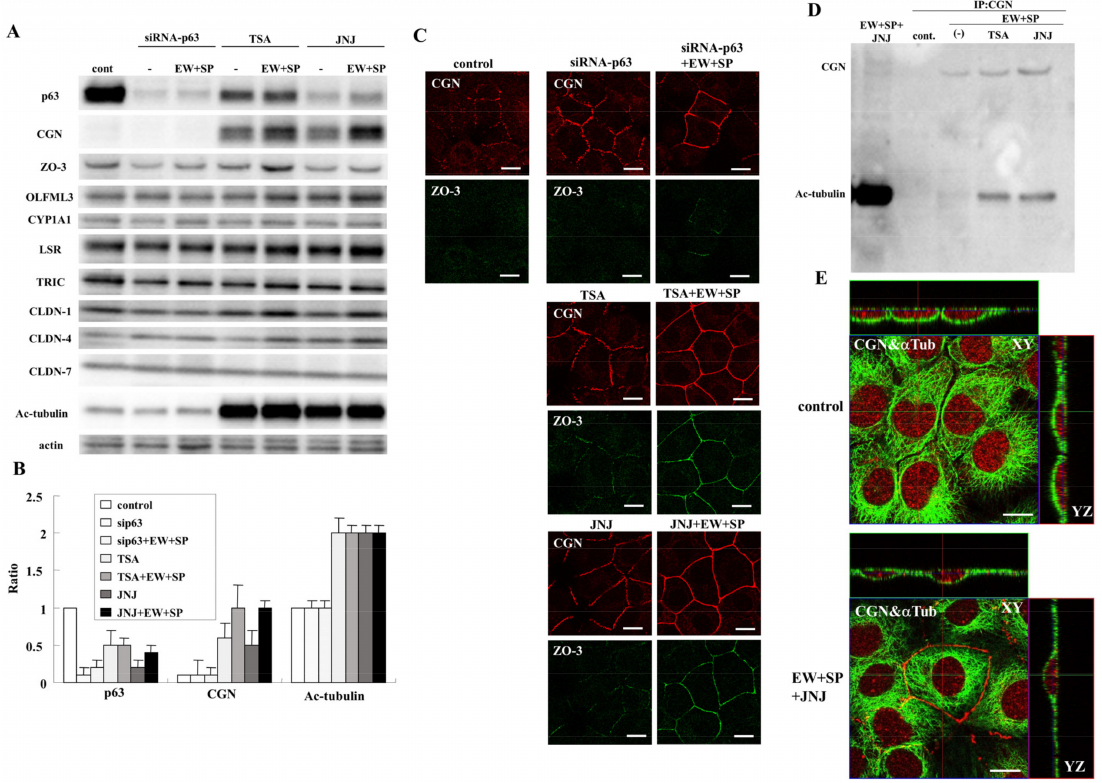
Figure 3. ( A ) Western blotting for p63, CGN, ZO-3, OLFML3, CY1A1, angulin-1/LSR, TRIC, CLDN-1, CLDN-4, CLDN-7, Ac-tubulin, and actin in A253 cells transfected with siRNA-p63 and treated with TSA and JNJ at 10 µ M with or without EW-7197 and SP600125 at 10 µ M. ( B ) The results of ( A ) are shown as a bar graph. ( C ) Immunocytochemical staining for CGN and ZO-3 in A253 cells transfected with siRNA-p63 and treated with TSA and JNJ at 10 µ M with or without EW-7197 and SP600125 at 10 µ M. Scale bar: 10 µ M. ( D ) Coimmunoprecipitation in A253 cells treated with or without TSA and JNJ at 10 µ M in the presence of EW-7197 and SP600125 at 10 µ M. Immunoprecipitation using anti-CGN antibody led to the identification of Ac-tubulin in Western blot analysis. ( E ) Double- immunocytochemical staining for CGN and α -tubulin in A253 cells treated with JNJ at 10 µ M in the presence of EW-7197 and SP600125 at 10 µ M. Scale bar: 10 µ